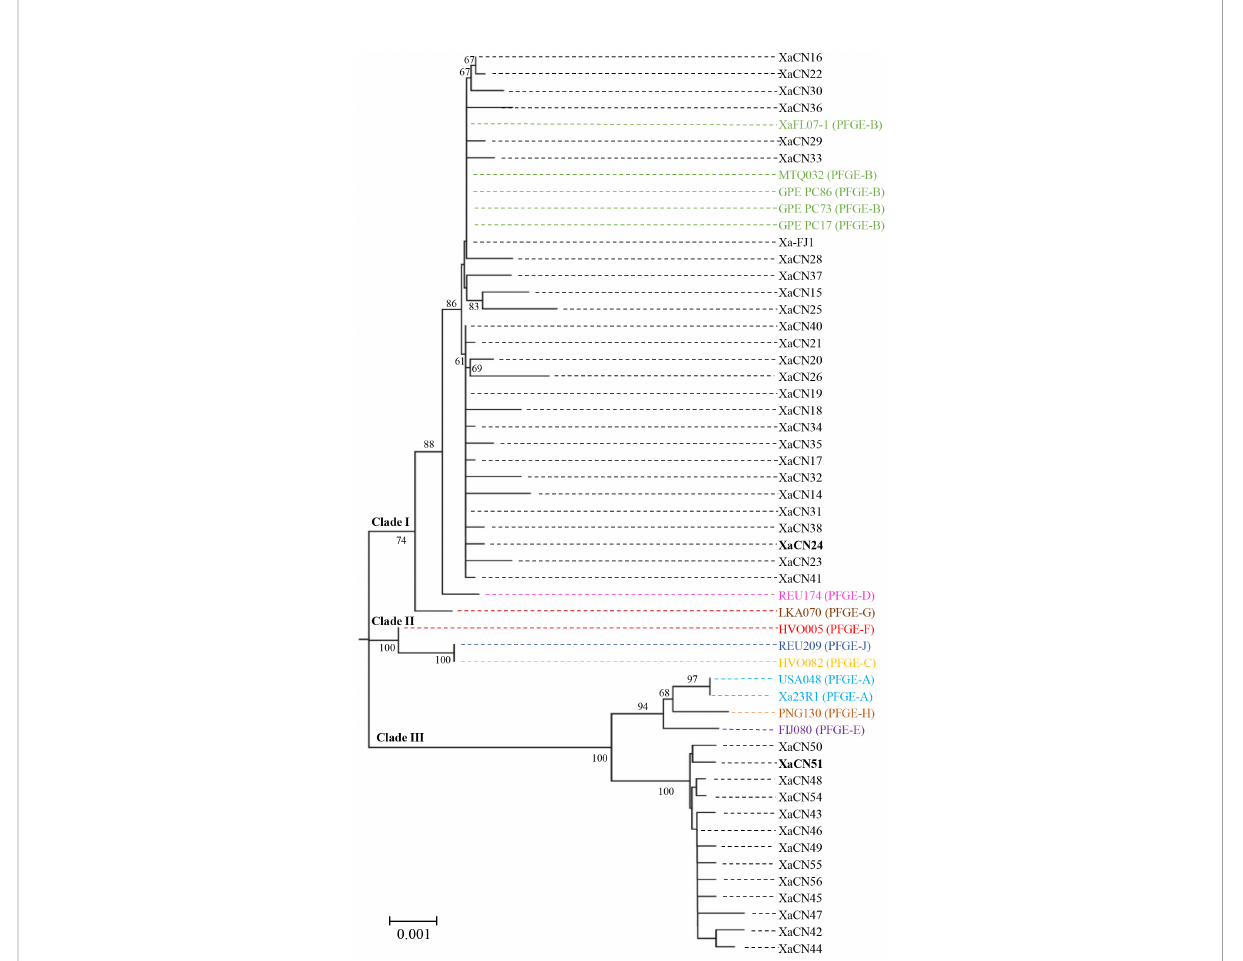
FIGURE 1 Neighbor-joining phylogenetic tree constructed with the concatenated sequence (4,165 nucleotides) of four housekeeping genes of 54 strains of Xanthomonas albilineans (40 from China and 14 from other geographical locations). Bootstrap values were determined for 1,000 replications and only bootstrap values >60% are shown at nodes. Strains XaCN24 and XaCN51 used for molecular investigations in planta are in bold. Strains from different pulsed- fi eld gel electrophoresis (PFGE) groups (A-H, and -J) are written with different